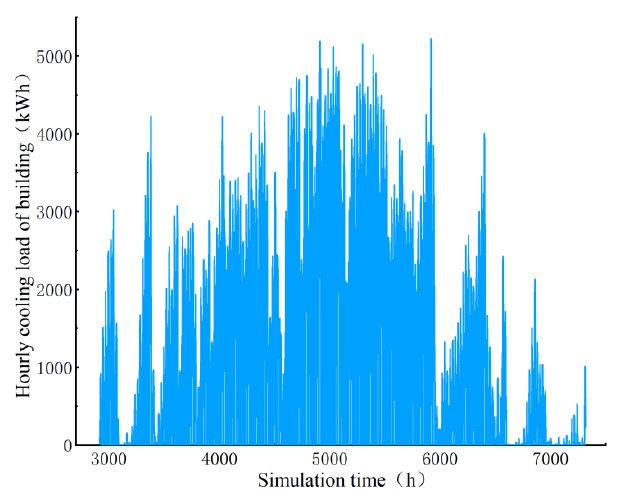
Figure 4. The geometry model of the library building.